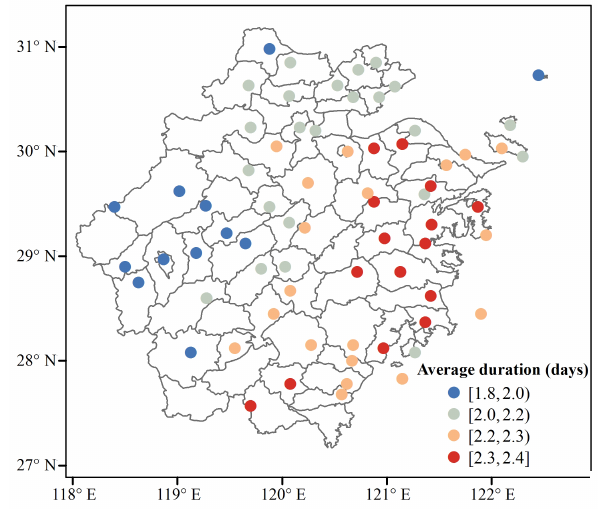
Figure 4. Average duration (days) of typhoon precipitation at each station in Zhejiang Province from 1980 to